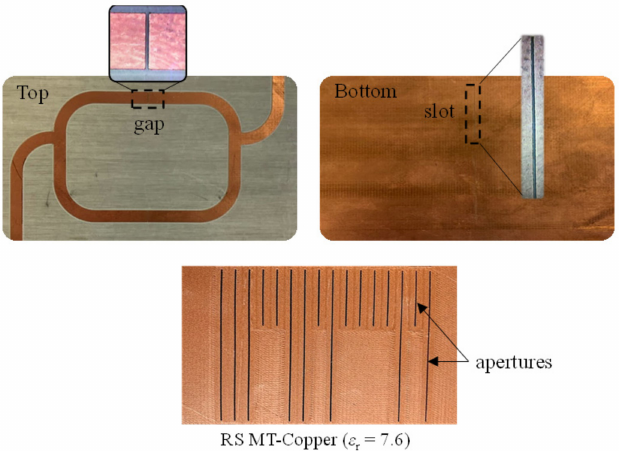
Figure 18. 3D-printed quasi-absolute all-dielectric permittivity contrast position encoder and reader based on a pair of slot resonators [27].